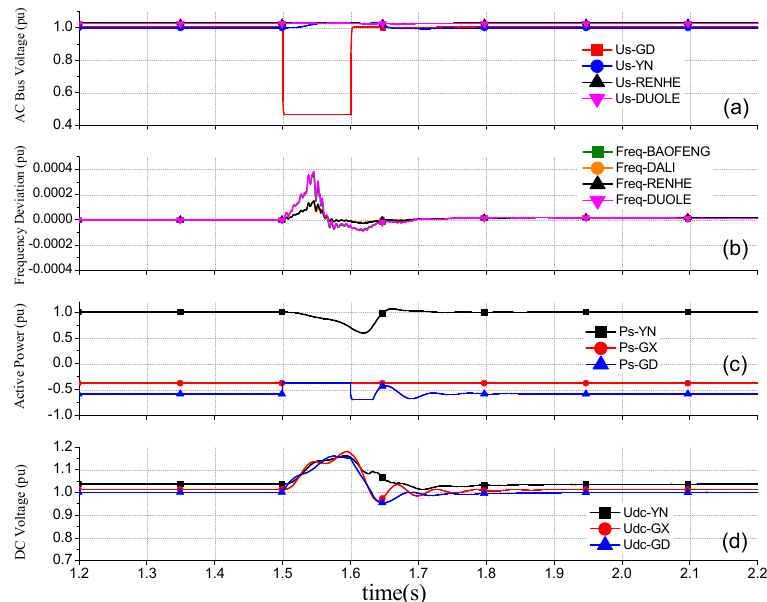
Figure 11. Dynamic performances of the hybrid multi-terminal HVDC system under GD bus fault. ( a ) AC bus voltage; ( b ) Frequency deviation; ( c ) Active power; ( d ) DC